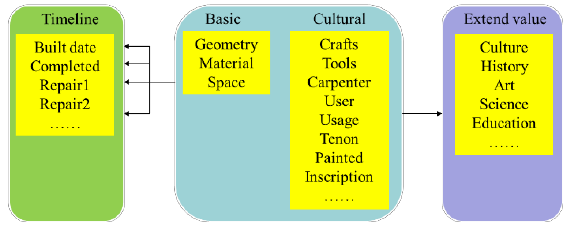
Figure 3. Data structure of building component